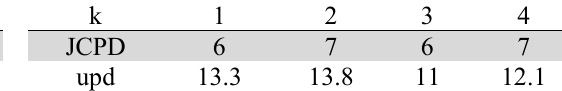
Number of job created and Unemployment rate in plants and distribution centers (JCPP j and JCPD k ) (person)